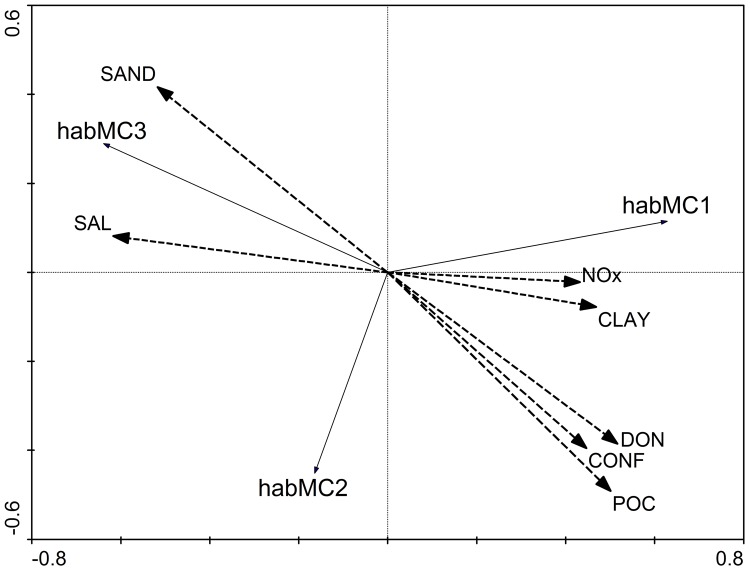
Biplot of the RDA parsimonious model explaining fuzzy memberships for the three habMCs.